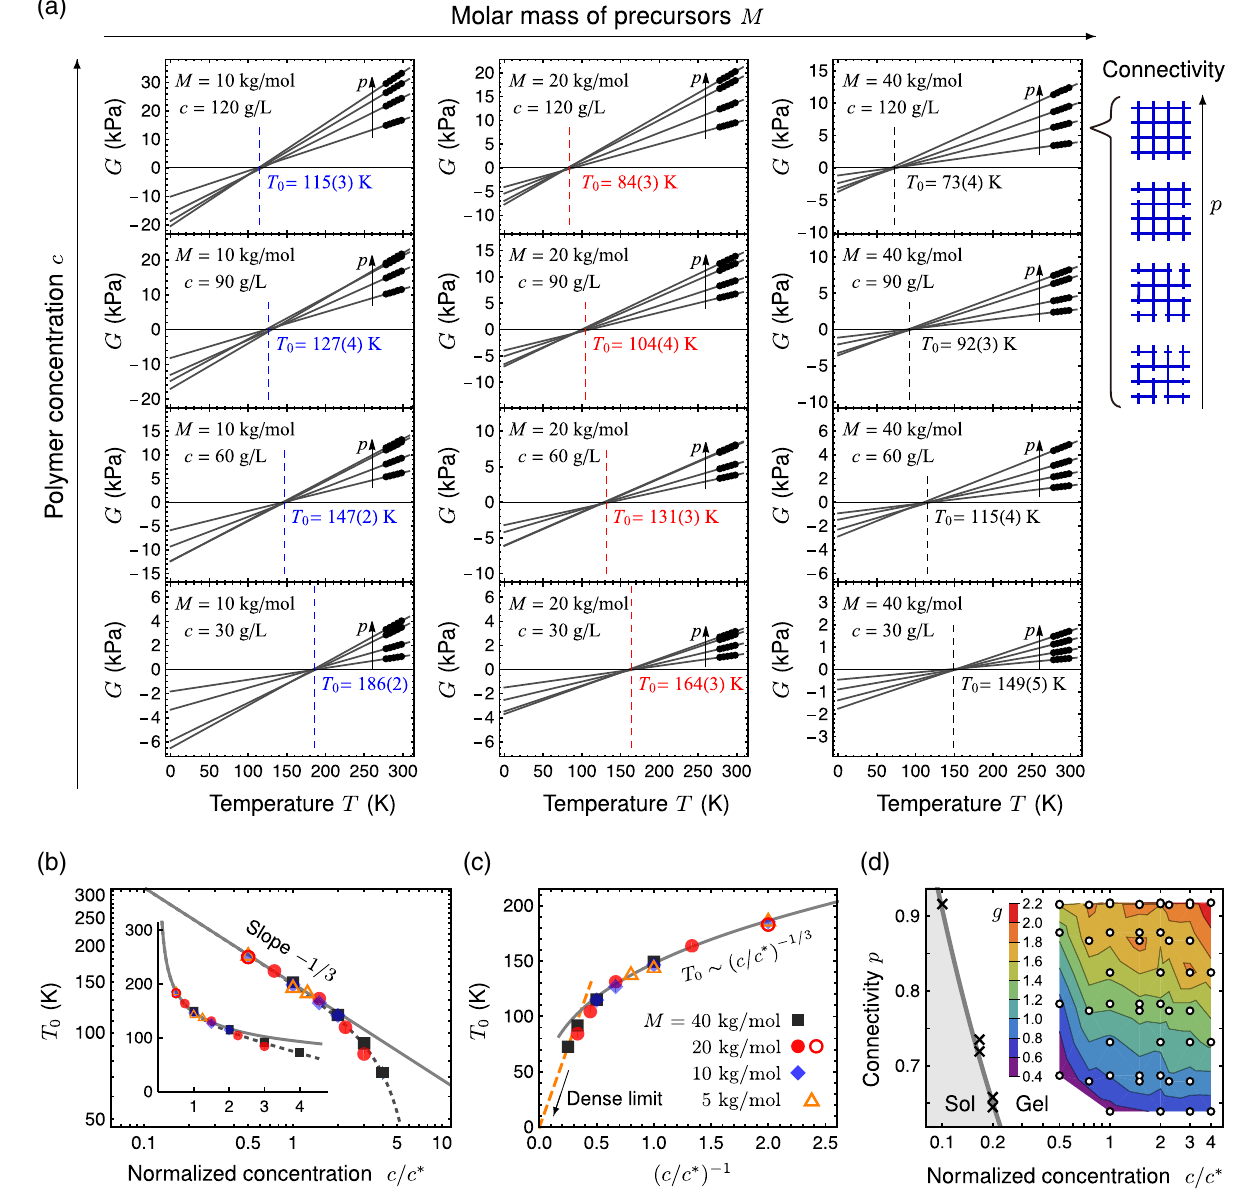
FIG. 5. The existence of a universal function that governs the energy contribution of gel elasticity. (a) Temperature ( T ) dependence of shear modulus G . We obtain each gray line from a least-squares fit of each sample, which is characterized by the three parameters of the precursors: the molar mass M , the concentration c , and the connectivity p . All gray lines that have the same M and c pass through a vanishing temperature T 0 on the T axis, which leads to Eq. (7). The value of T 0 in each graph is the average of the four samples with different values of p , and the values in parentheses represent the standard deviation. (b,c) Normalized concentration ( c=c (cid:3) ) dependence of T 0 . We set c (cid:3) ¼ 80 , 60, 40, and 30 g = L for M ¼ 5 , 10, 20, and 40 kg = mol, respectively, to construct the master curve. The orange triangles, blue diamonds, red circles, and black squares represent M ¼ 5 , 10, 20, and 40 kg = mol, respectively. Each filled symbol represents the average of four samples taken from (a). Additionally, each open symbol represents the value of one equal-weight mixing sample ( p ≃ 1 ). (b) Log-log (main panel) and linear (inset) plots of c=c (cid:3) vs T 0 , which demonstrate the scaling law T 0 ∼ ð c=c (cid:3) Þ − 1 = 3 in the dilute regime ( c=c (cid:3) < 1 ). (c) A linear plot of the inverse normalized concentration ð c=c (cid:3) Þ − 1 vs T 0 , which demonstrates that T 0 becomes nearly zero in the dense limit [ ð c=c (cid:3) Þ − 1 → 0 ]. This result agrees with j G elasticity as given in previous studies [5 – 8,10]. (d) Connectivity p and c=c (cid:3) dependence of g . We obtain the contour plot from data points (white circles) that represent samples shown in (a). The sol-gel transition line (gray thick line) is the interpolation of data (black crosses) taken from Ref.